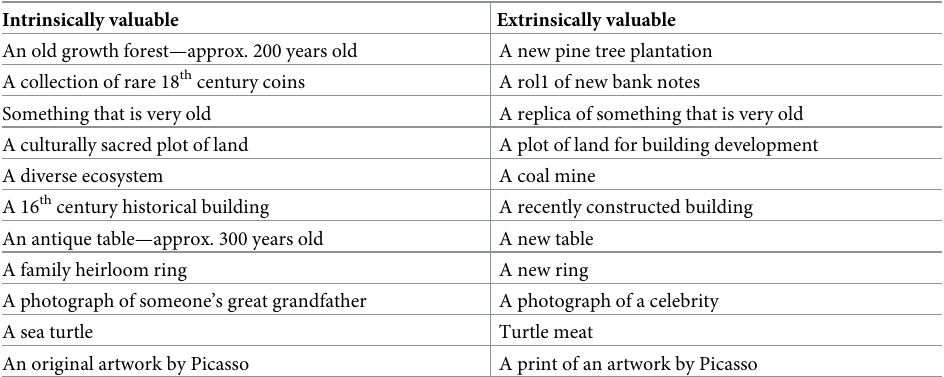
Table 1. Twenty-two entities presented to participants in Studies 1, 2, and